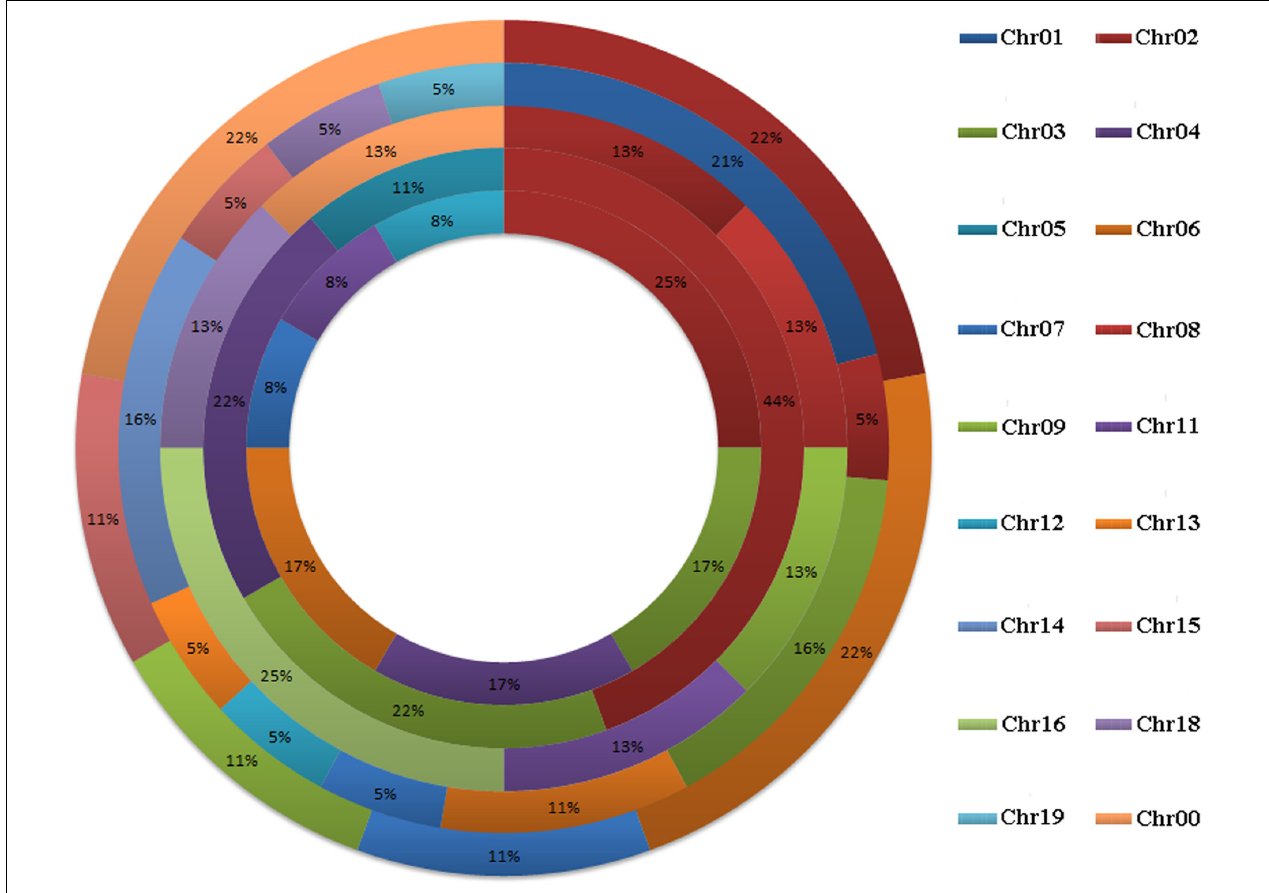
FIGURE 1 | Chromosomal distribution and percentage share of GRF genes in pear, Populus , Arabidopsis , grape and Oryza sativa . The outermost ring represents chromosomes of pear, followed by Populus , grape, and Arabidopsis , and the innermost ring represents Oryza sativa